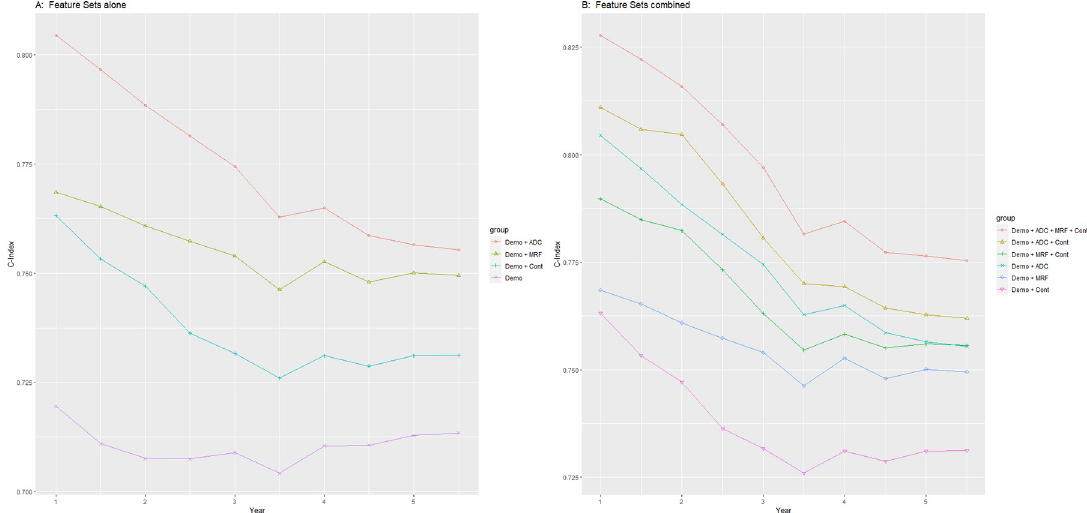
Fig 3. Max model plots with features sets and demographics. Demo is Demographics of age/sex/race. Cont is Continuous (Sensor) Features. MRF is Modifiable Risk Factors (Categorical) Features, ADC is Advanced Disease Condition (Categorical) Features.